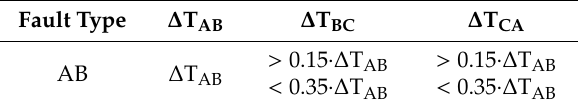
( b ) Figure 7. Instantaneous values of scalar products based on superimposed quantities theory for AB fault when current contribution comes from SG ( a ) or Type 4 WT ( b ). ( a ) ( b ) Figure 8. Instantaneous values of scalar products based on superimposed quantities theory for ABG fault when current contribution comes from SG ( a ) or Type 4 WT ( b ).